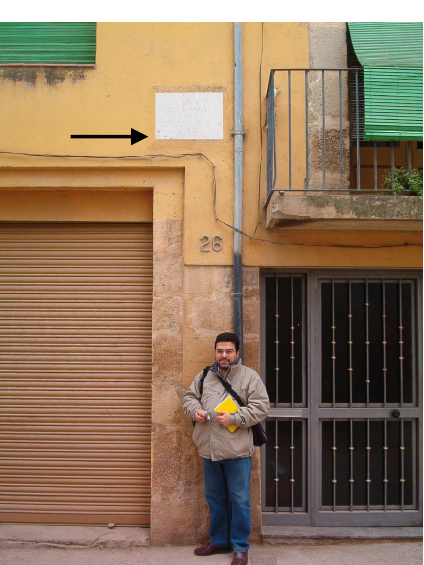
Fig. 3. Epigraphic limnimark or flood mark at Sant Agust´ı street in T`arrega, pointing the maximum water level reached by the Santa Tecla ’s flood.